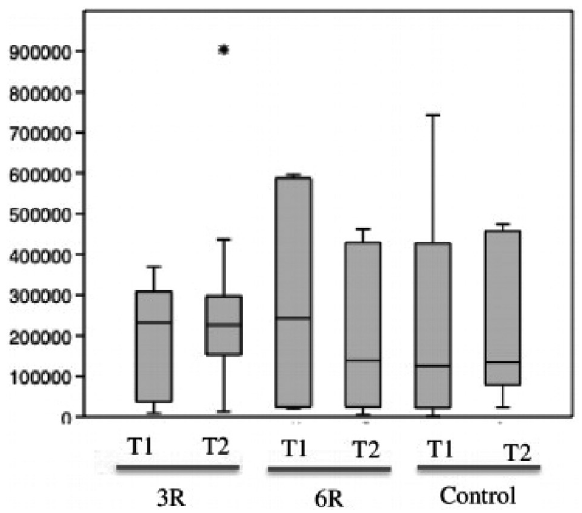
Figure 3- Boxplot of the number of colonies of the three groups at the two consultations (T1: initial examination and T2: two- week follow-up examination). Boxplot (median, minimum and maximum values, outliers, and quartiles). When the three groups’ T2 results were compared, the Kruskal-Wallis test and ANOVA revealed no significant differences between the numbers of colonies (p=0.577 and p=0.593, respectively). When the initial consultations (T1) and final consultations (T2) were compared, the 6R group exhibited a greater reduction in the number of bacterial colonies after the use of the X technique. In contrast, the 3R group exhibited a disparity: a greater number of bacterial colonies were found in T2 than in